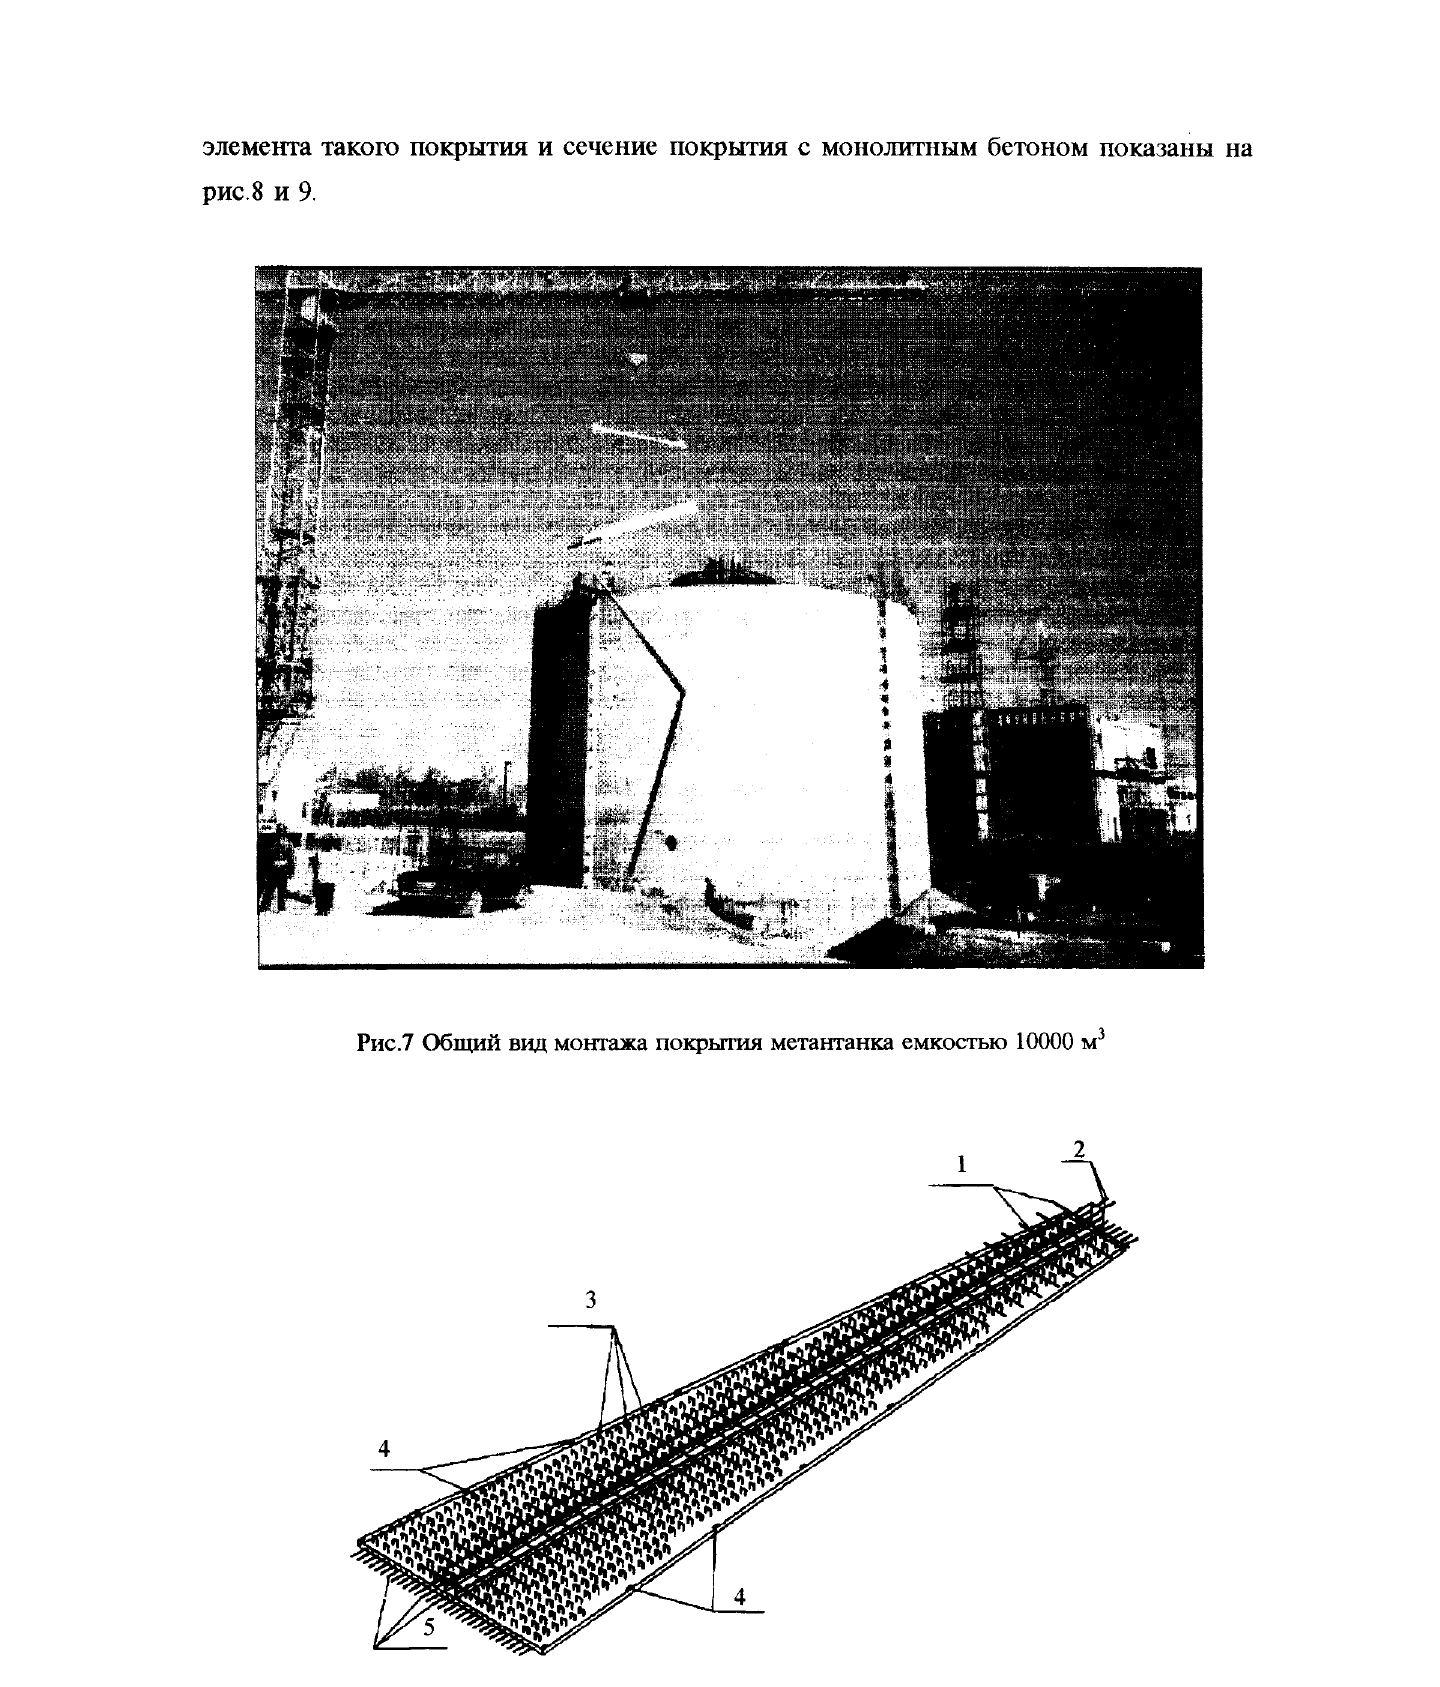
Puc.8. C6opHa.H ruiUTa c6opHo-MoHOJIUTHoro noKphiTH.H MeTaHTaHKa: 1, 5 - apMarypa IJJIIIThi, 2